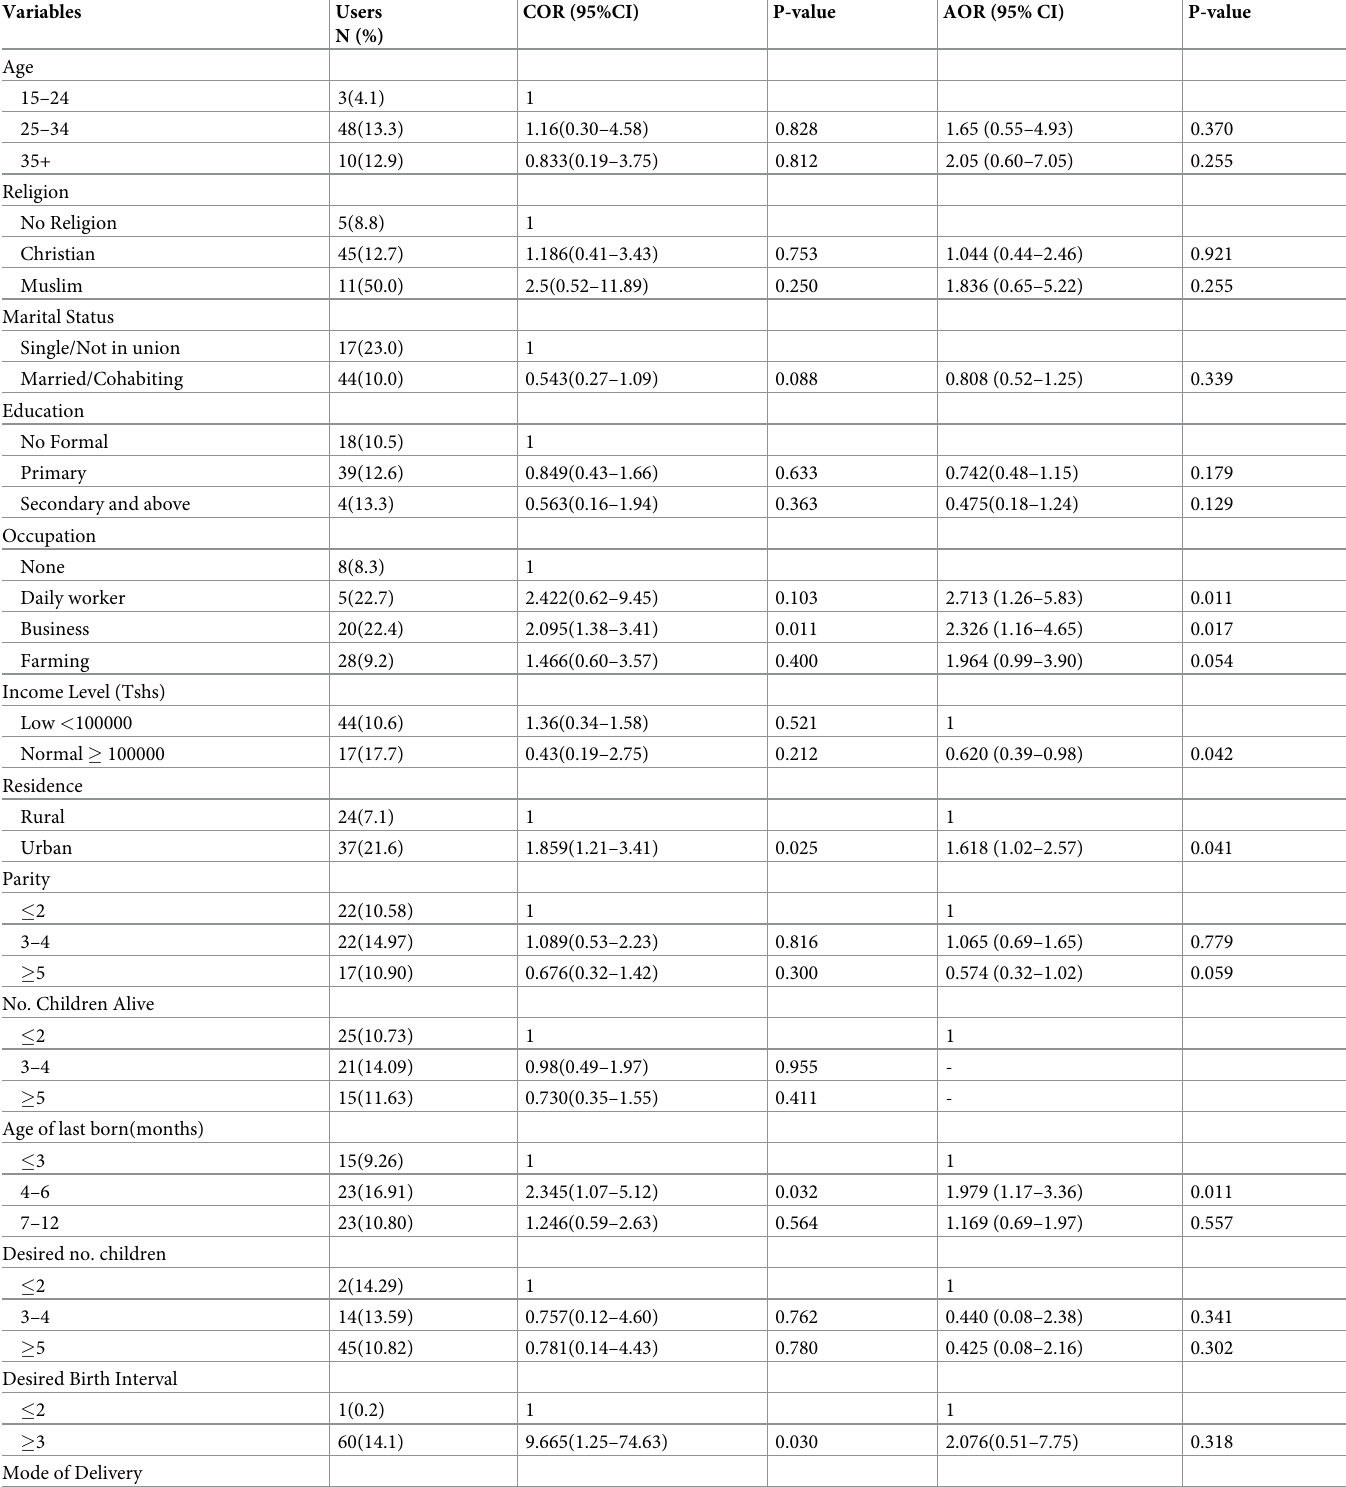
Table 3. Socio-demographic characteristics associated with postpartum modern contraceptive use (N =